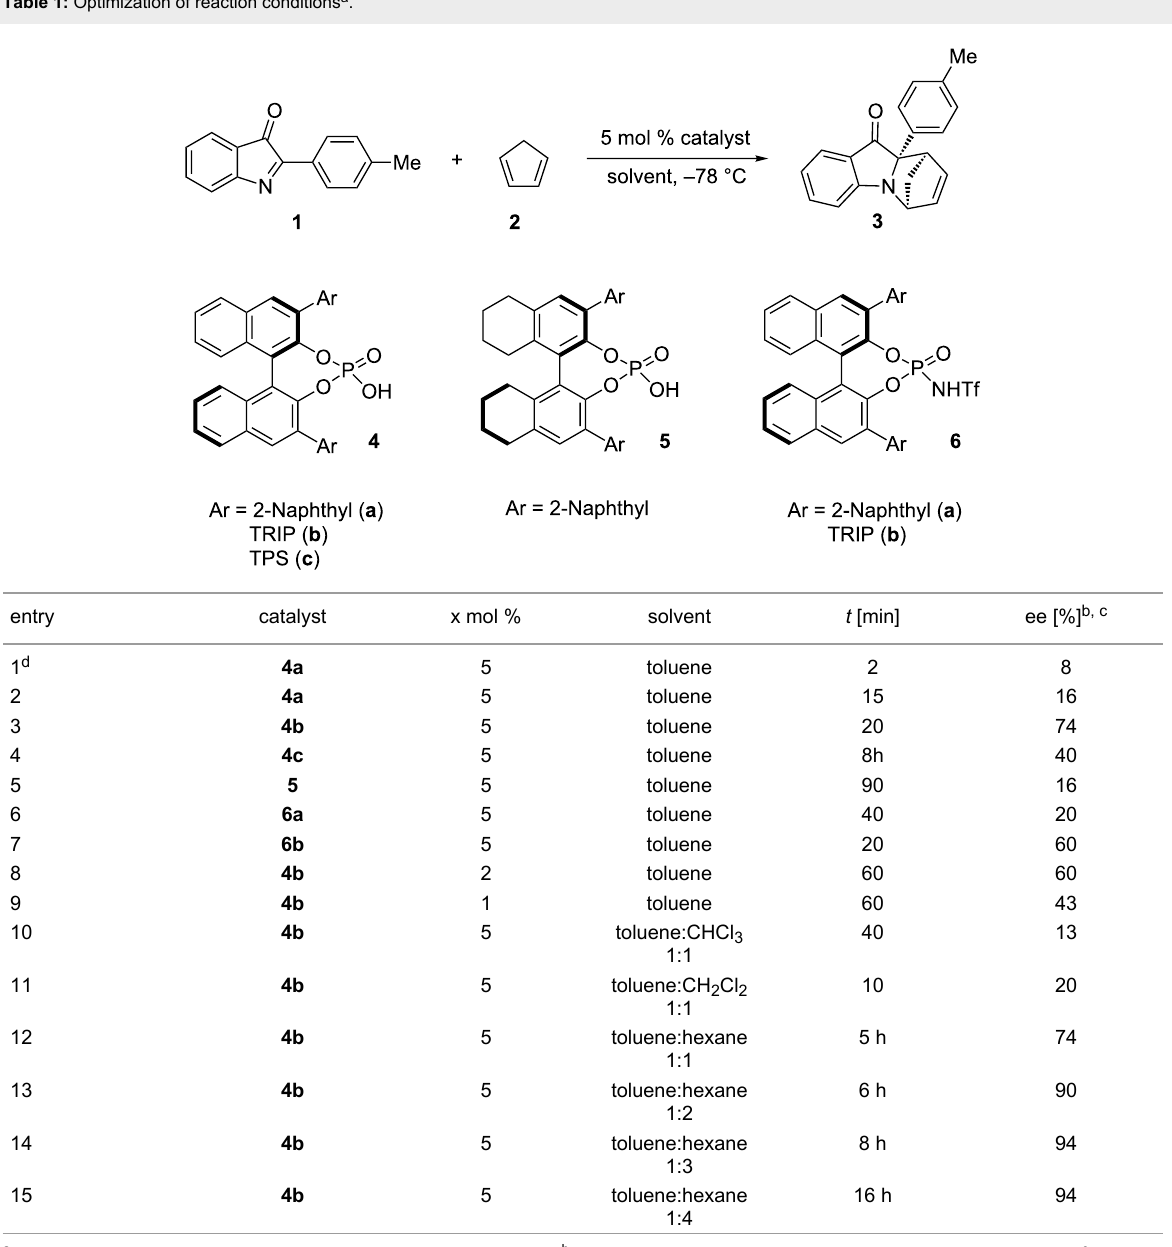
Table 1: Optimization of reaction conditions a